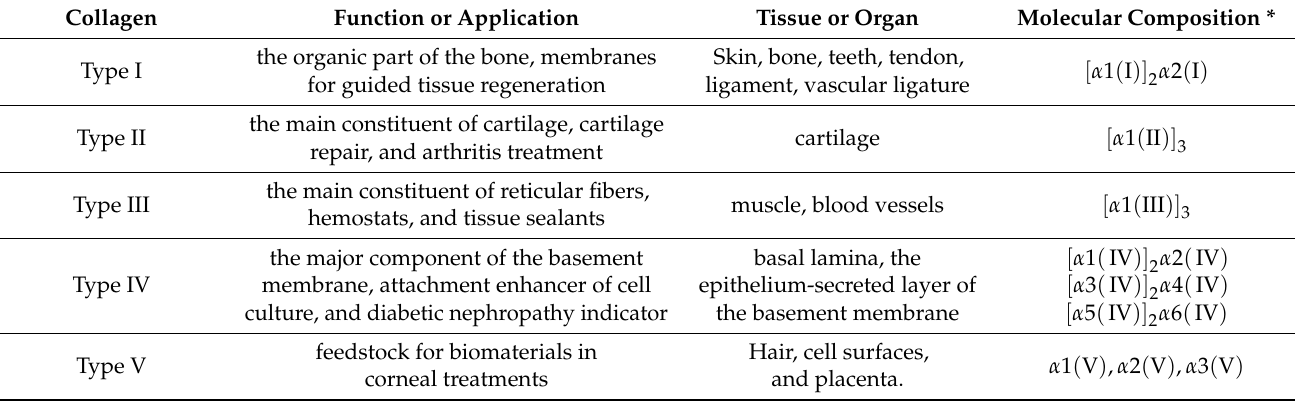
Table 1. The function of the 5 most common types of collagen.